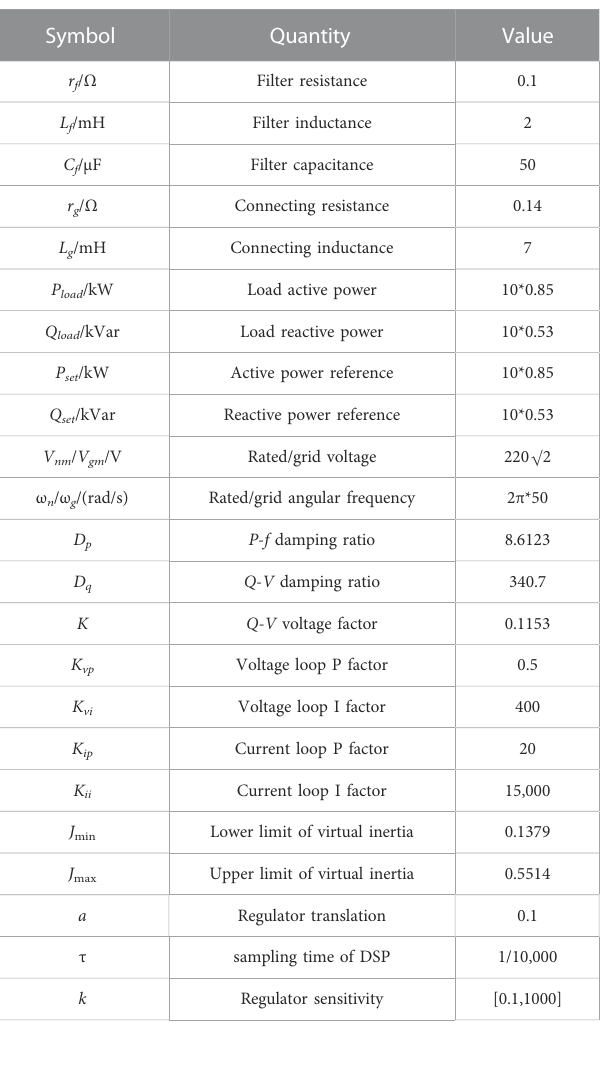
TABLE 1 Parameters of GFM